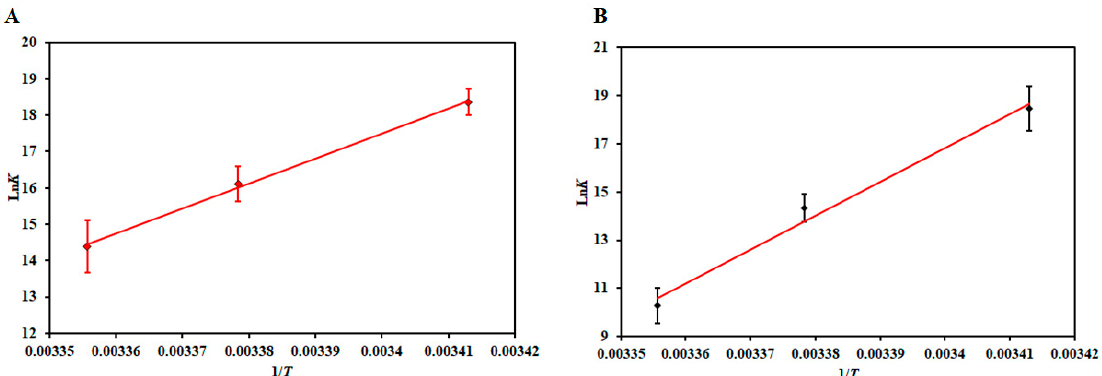
Figure 4. Van’t Ho ff plot for ( A ) MARK4 − DP and ( B ) MARK4 − RT interaction at three di ff erent Figure 4. van’t Hoff plot for (A) MARK4 − DP and (B) MARK4 − RT interaction at three different temperatures. Table 2. Thermodynamic parameters obtained from fluorescence quenching studies carried out at different temperatures.